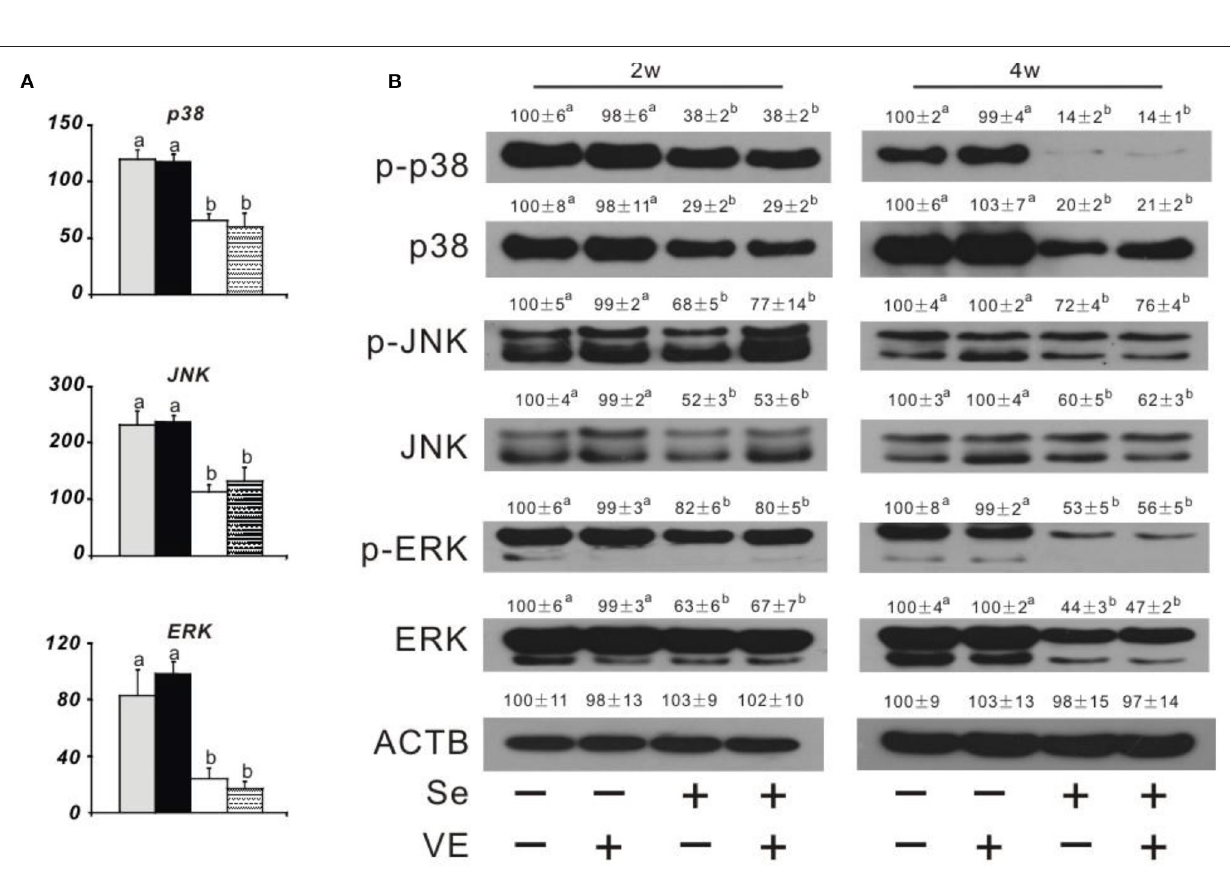
Frontiers in Physiology | www.frontiersin.org